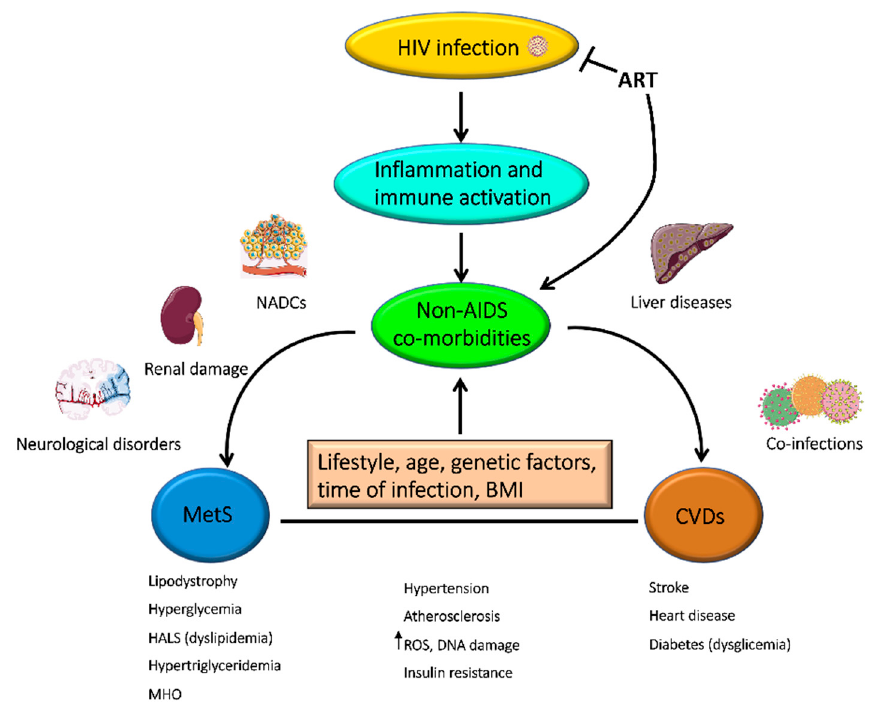
Figure 2. HIV causes persistent inflammation and chronic immune activation. Over the years and despite effective ART, this altered immunological status could lead to the development of non-AIDS co-morbidities in people living with HIV (PLWH). Many of these are identified as cardiovascular diseases (CVDs) or metabolic syndrome (MetS). NADCs: non-AIDS-defining cancers; HALS: HIV-associated lipodystrophy syndrome; MHO: metabolically healthy obesity; ROS: reactive oxygen species; BMI: body mass index. Images were obtained from Servier Medical Art images (http://smart.servier.com/).